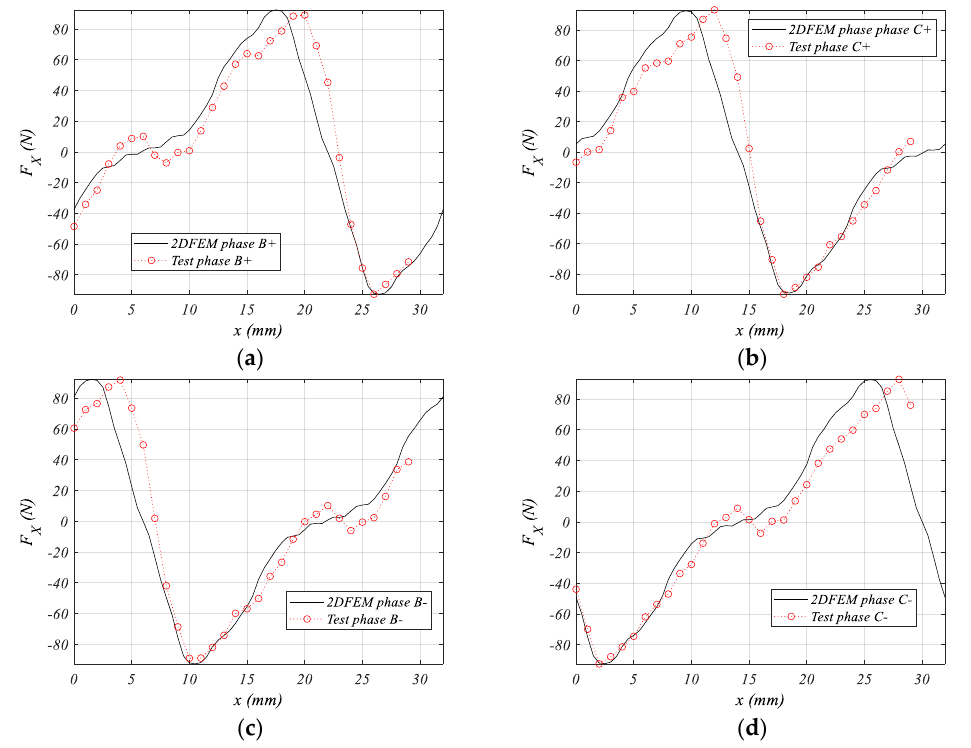
Figure 14. Propulsion force comparison results for J = 10 A/mm 2 , shift = 4 mm ( a ). Phase I B = 3.12A. ( b ) Phase I C = 3.12A. ( c ) Phase I B = −3.12A. ( d ) Phase I C = −3.12A.